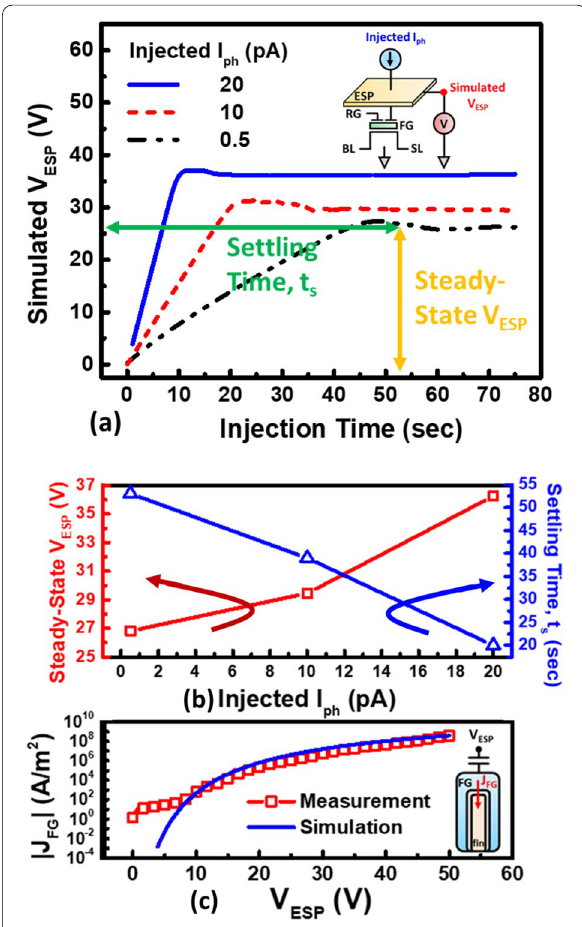
Fig. 8 a The transient response of simulated ESP potential under increasing injected I ph . And b the steady‑state V ESP and the settling time under different I ph injection, and c measured and simulated FG tunneling current density ( J FG ) induced by ESP potential